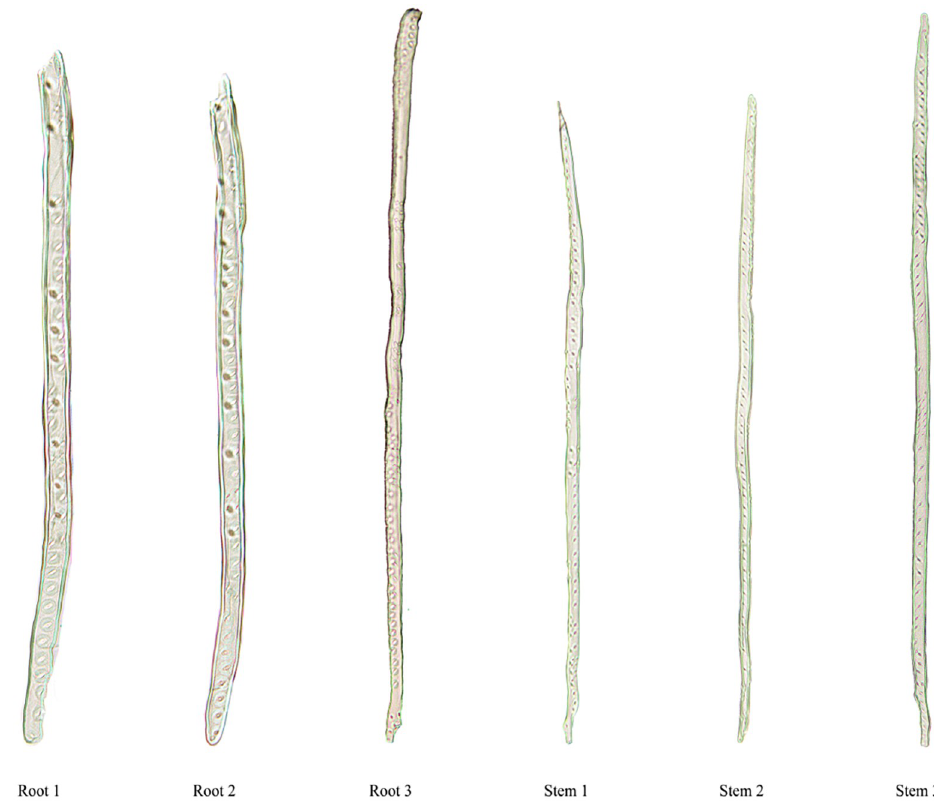
Fig 9. Schematic diagram of the single tracheid